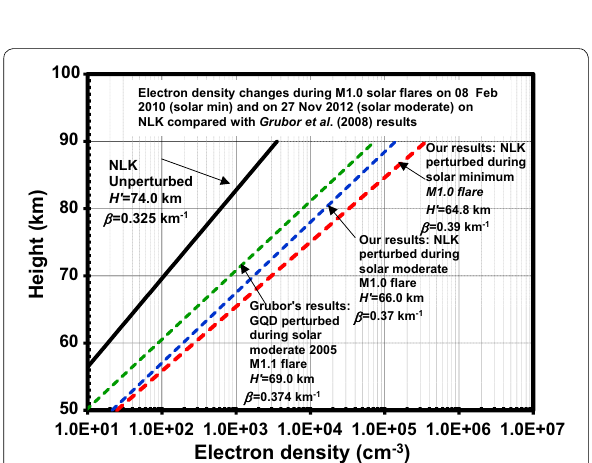
Fig. 10 Δ H ′ versus flare power for the two signal paths during periods of low and moderate solar activity. Δ H ′ H ′ is the quiescent-level ionospheric reflection height and H ′ p is the reflection height during the solar flare peak